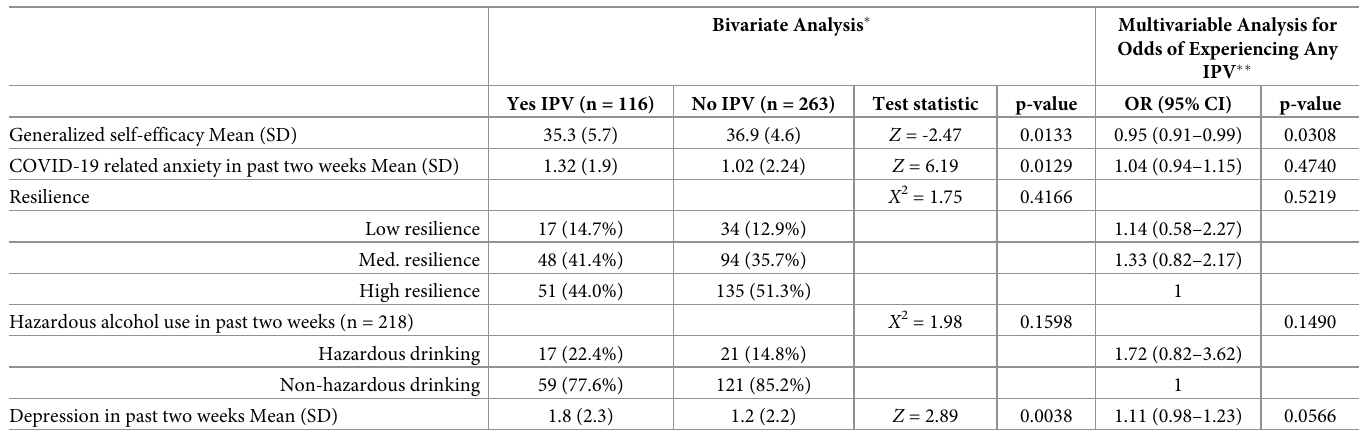
Table 4. Mental health, resilient coping, general self-efficacy, and hazardous alcohol use by experience of any IPV victimization in past 6 months (n = 379).